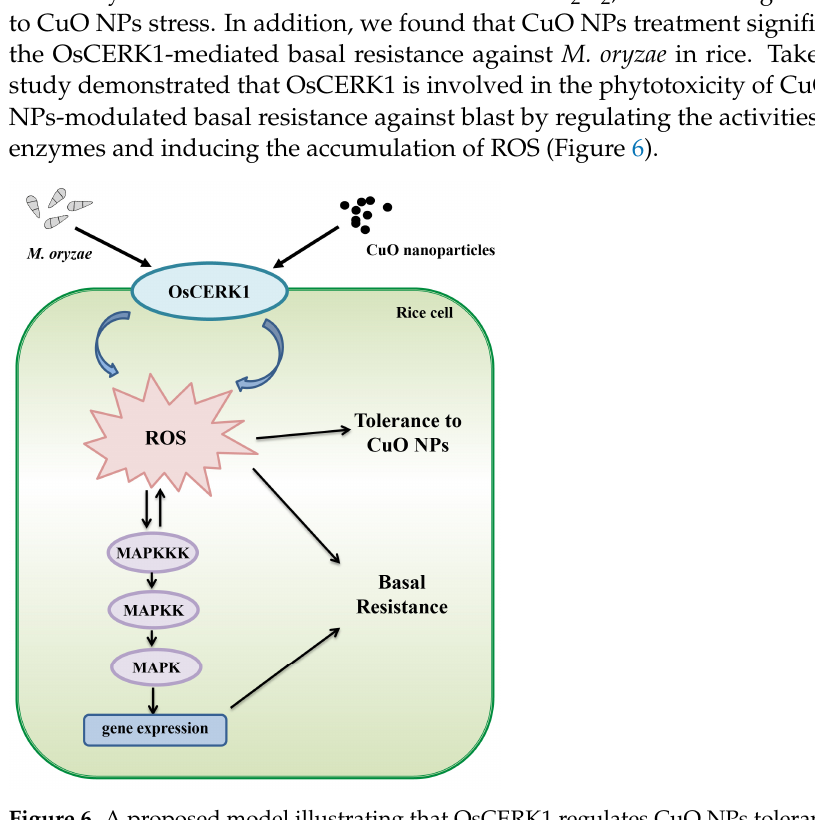
Figure 6. A proposed model illustrating that OsCERK1 regulates CuO NPs tolerance and CuO NPs- modulated blast resistance in rice. On the surface of rice cells, OsCERK1 senses the signals of CuO NPs stress and M. oryzae to regulate antioxidant system, resulting in increased ROS accumulation. The excessive ROS accumulation in the cell leads to growth inhibition but enhances the basal resistance against M. oryzae in rice.